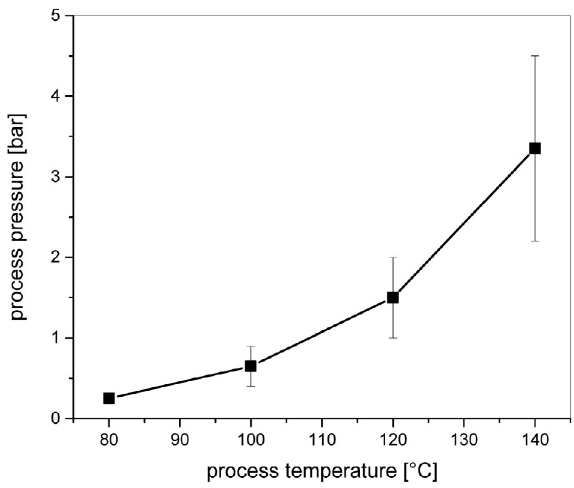
Figure 1. Process pressure as function of the set process tempera- ture in the used solvothermal arrangement. The error bars indicate the range of process pressures observed during the whole process time of 5 minutes.